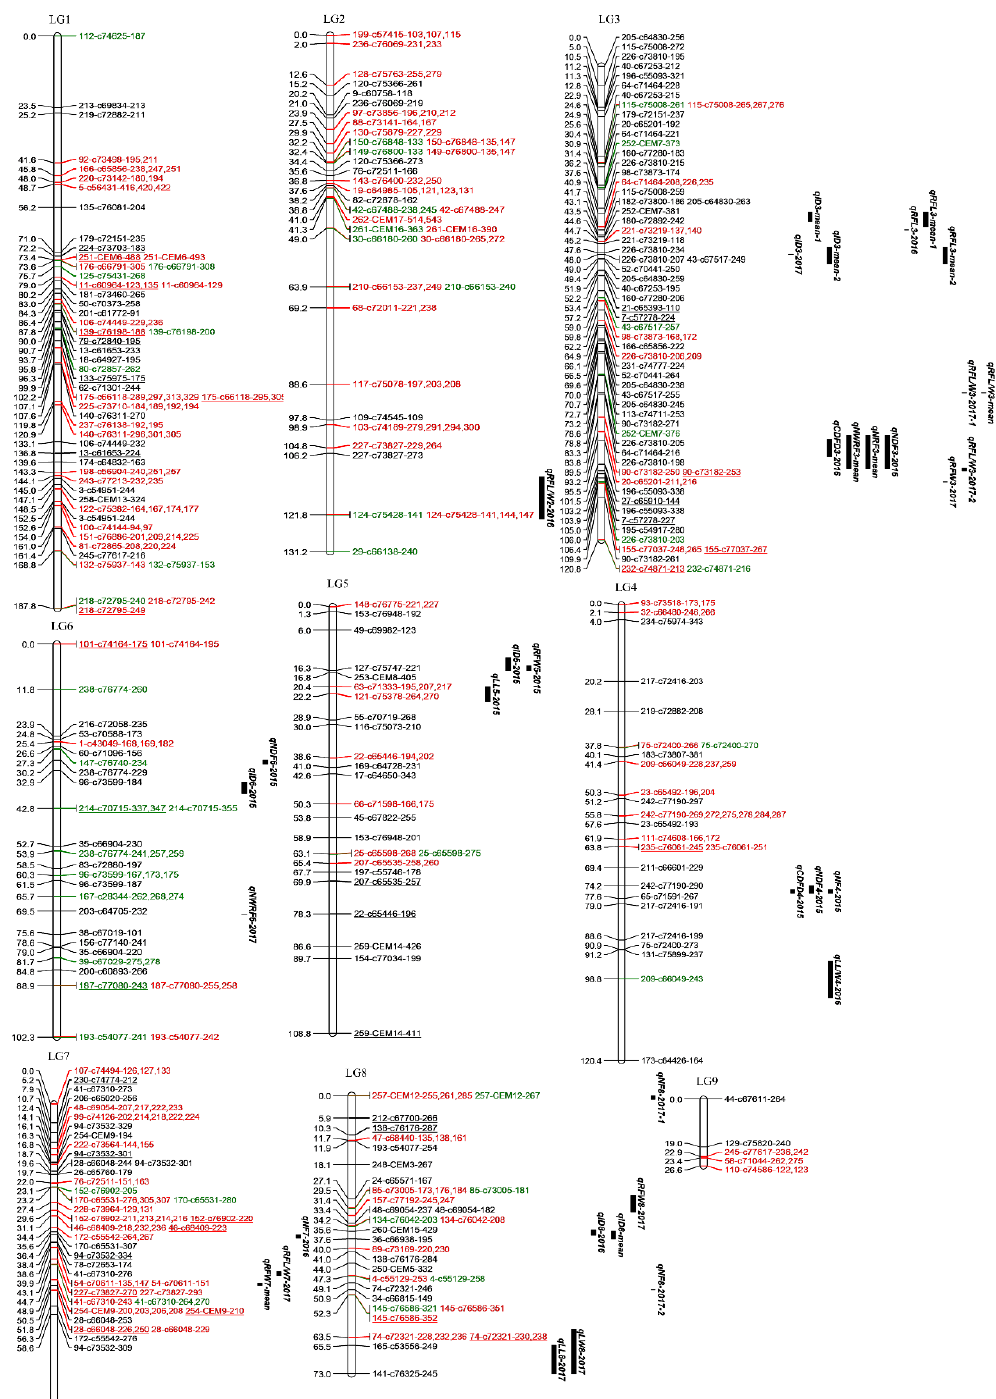
Figure 1. Final integrated map derived from an F 1 population of 192 offspring in chrysanthemum. Map distances (cM) and SSR marker alleles are shown on the left and right side of each linkage group, respectively. Duplex markers are marked in green. Bridge markers are marked in red. Distorted segregating markers are underlined, which are indicated by a significant p value in the chi-squared test: p < 0.01; Quantitative trait loci are located on the far right of each LG.